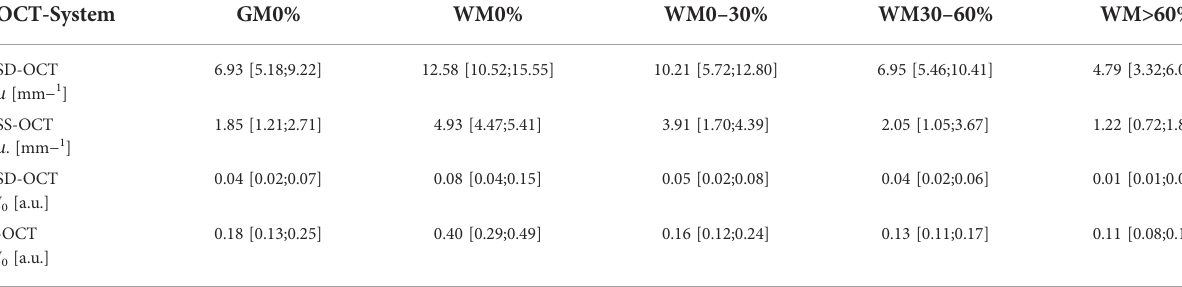
TABLE 2 Numerical values of the optical properties determined over all pathologies for the two OCT systems. OCT-System